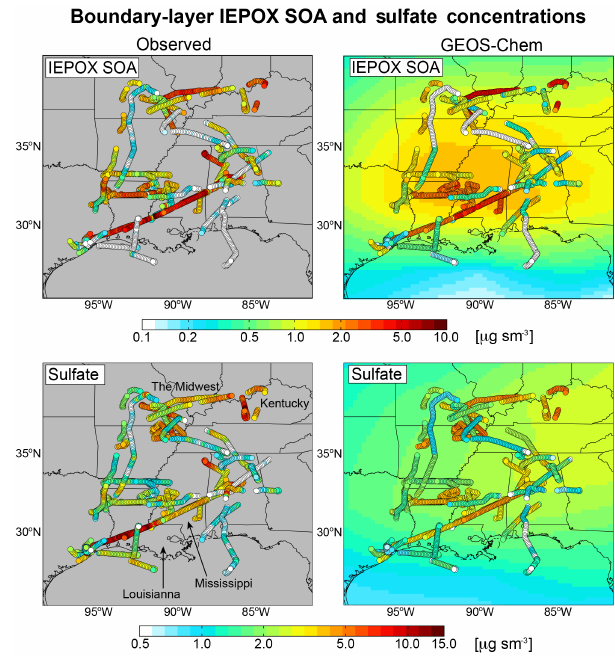
Figure 6. Spatial distributions of IEPOX SOA and sulfate concen- trations in the boundary layer ( < 2km) over the southeast US during SEAC 4 RS (August–September 2013). Aircraft AMS observations of IEPOX SOA (top left) and sulfate (bottom left) are compared to model values sampled at the time and location of the aircraft ob- servations (individual points) and averaged during the SEAC 4 RS period (background contours). Data are on a logarithmic